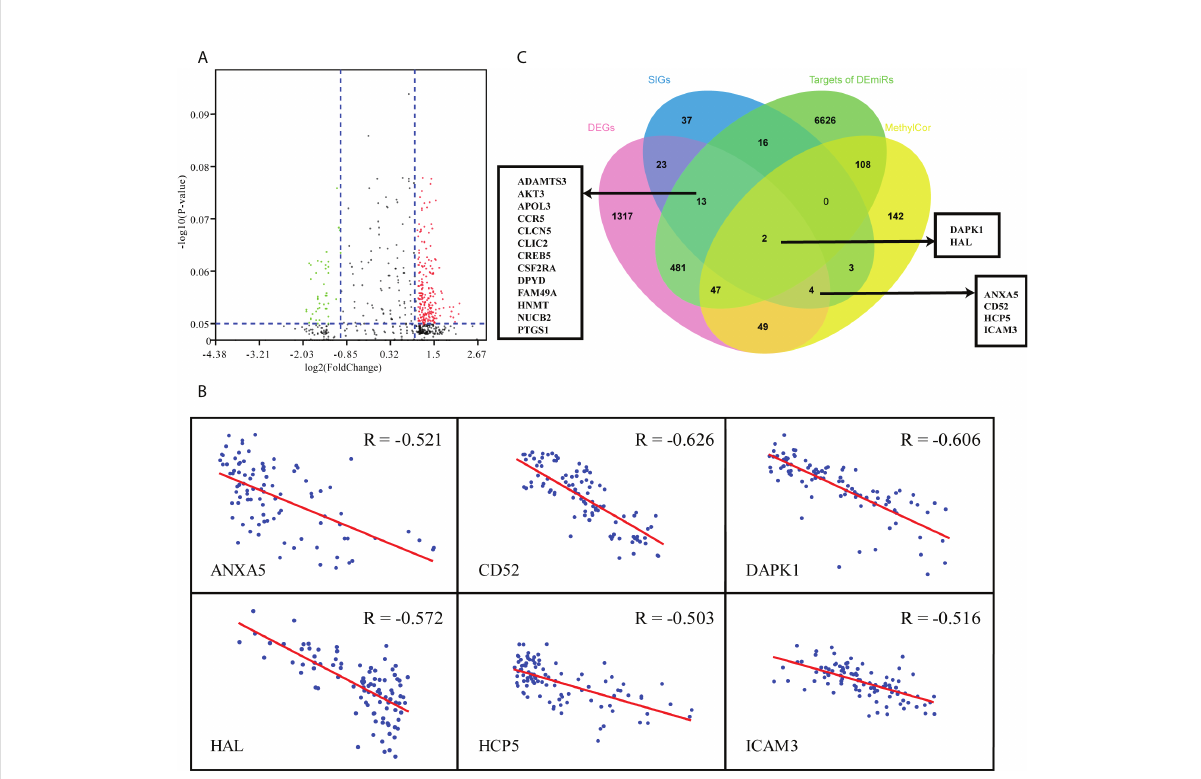
FIGURE 4 Multiomics analysis of 97 TCGA-AML patients. (A) Volcano plot of differentially expressed miRNAs between IL and IR types. (B) Correlation between mRNA expression and DNA methylation level of 6 DEG & MethylCor genes. (C) Venn plot of the intersection of DEGs, SIGs, targets of DEmiRs and MethylCor gene set.